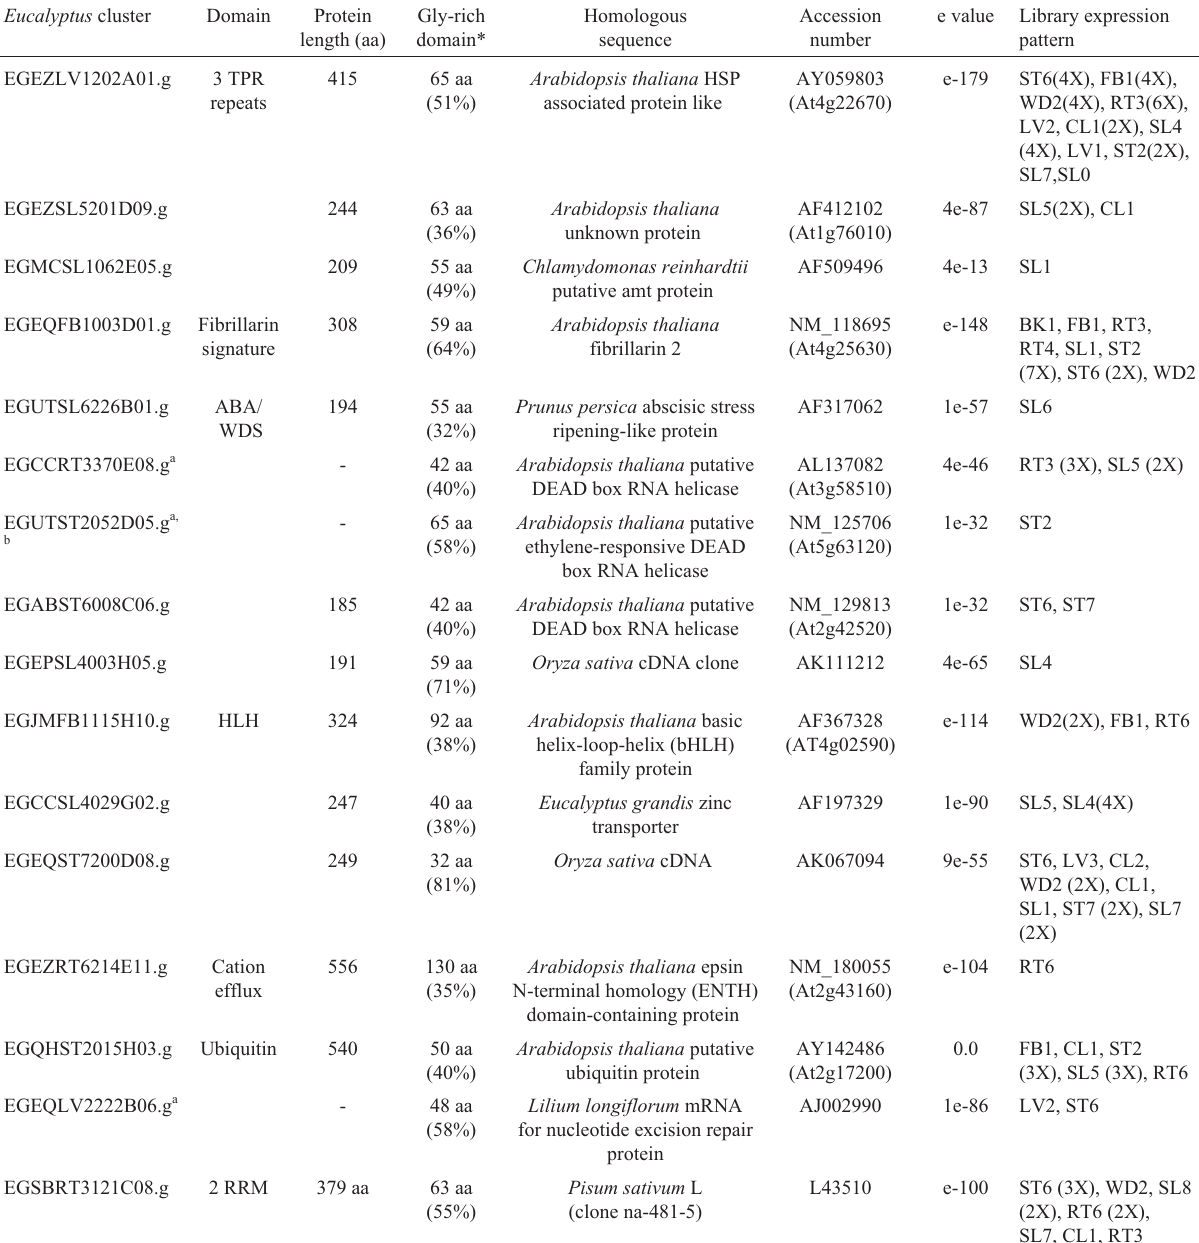
Table 10 - Eucalyptus ESTs encoding short glycine-rich domains. Eucalyptus